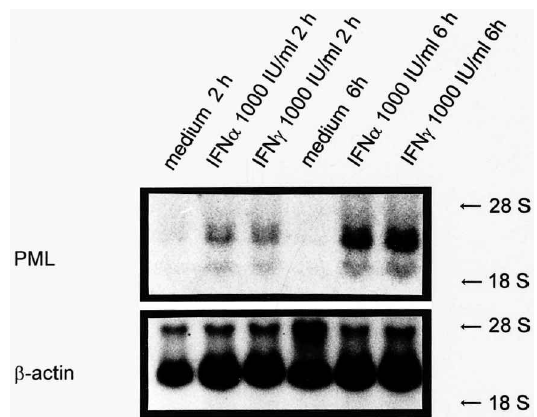
FIG. 4. Induction of PML-specific mRNA by IL-1 a and IFN- a . Human diploid foreskin fibroblasts were treated with IL-1 a (100IU/ml), with IFN- a (1000IU/ml) or with a combination of IFN- a (1000IU/ml) and IL-1 a (100IU/ml) for 6h. Cells were grown in the absence or presence of an inhibitor of protein tyrosine kinases (genistein 50 m g/ml). Northern blotting was performed as described above. For quantitative analysis, PML-specific transcript levels were analysed by densito- metric scanning and normalized to b -actin mRNA expression as described in Materials and